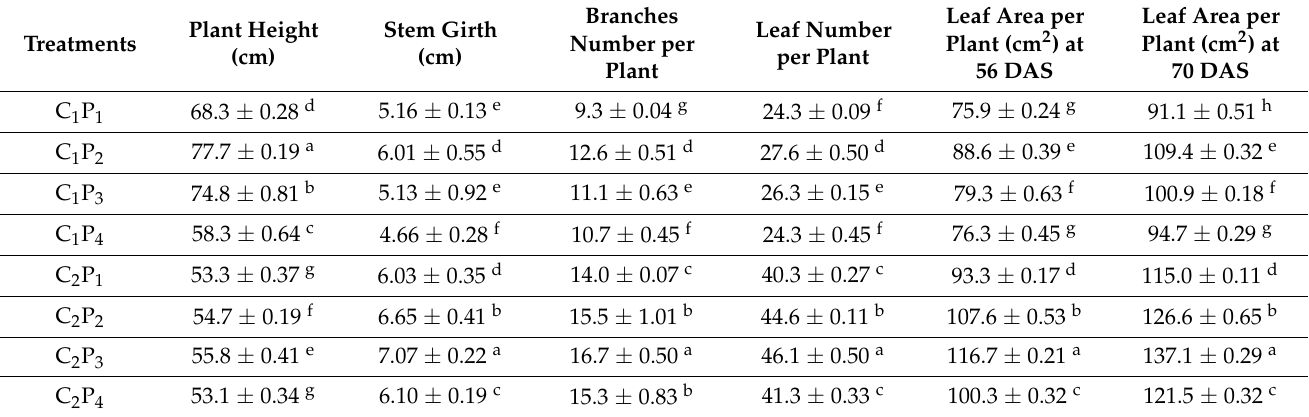
Table 1. Yield traits of cowpea under the interactive effect of genetic divergence and row configuration in a temperate